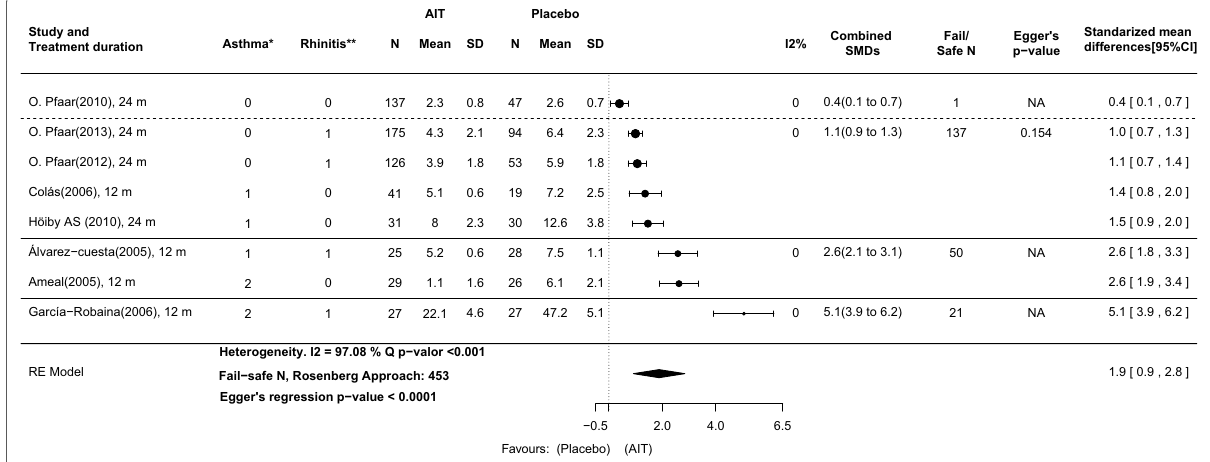
Fig. 2 AIT with DPAEs compared with placebo at the time of primary analysis in original publications. Outcome: combined symptom and medication score (cSMS) calculated with total scores from published articles. Four subgroups of asthma and rhinoconjunctivitis severity are delimited by solid and dashed lines. *Asthma classification: (0) Only intermittent asthma patients included; (1) Intermittent to mild persistent asthma patients included; (2) Intermittent to moderate persistent asthma patients included. **Rhinoconjunctivitis classification: (0) Any rhinoconjunctivitis severity included; (1) Moderate to severe rhinoconjunctivitis included. 95%CI: 95% confidence interval; m months, SD standard deviation, SMDs standardized mean